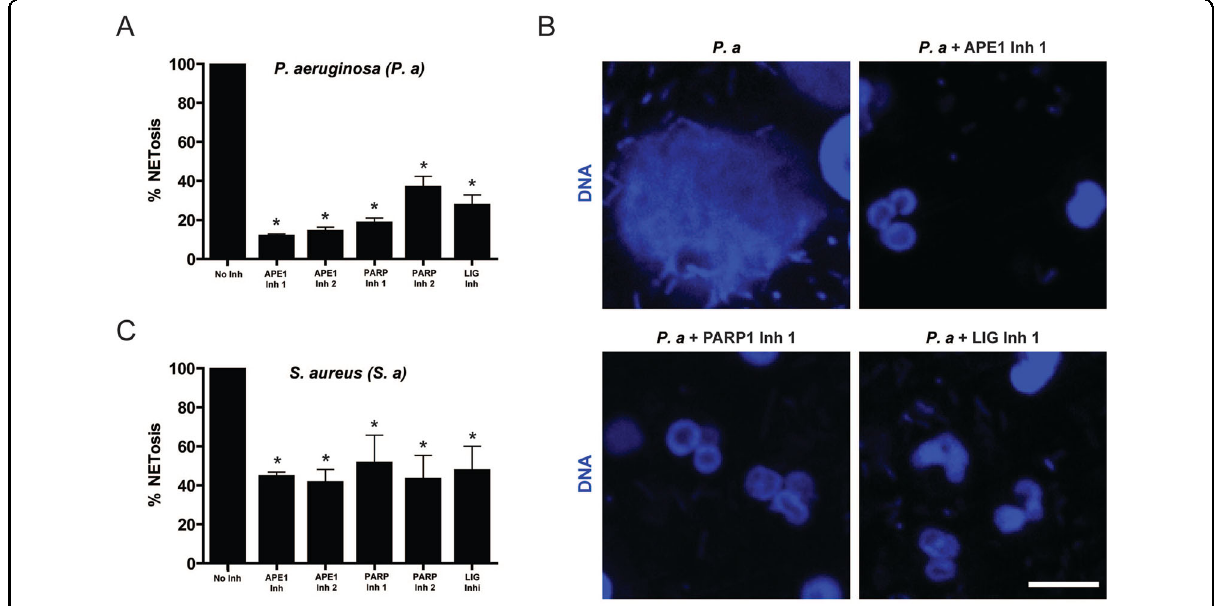
Fig. 4 Inhibition of early steps of BER suppresses NETosis induced by P. aeruginosa and S. aureus . A , C DNA release from neutrophils following media (-ve control), 20 MOI P. aeruginosa or 20 MOI S. aureus (RN4220) was measured using the SYTOX Green plate reader assay. Cells were preincubated with BER inhibitors (APE inh 1, CRT0044876 (125 μ M); APE inh 2, APE1 Inhibitor III (50 μ M); PARP1 inh 1, BSI201 (100 μ M); PARP inh 12, PJ34 (50 μ M) or LIG inh, L189 (100 μ M)) for 1 h prior to bacterial treatment. The data are presented a mean ± SEM ( n = 3; * p < 0.05 compared to the control with no inhibitors). B Neutrophils were incubated with DNA repair inhibitors, that inhibited NETosis, for 1 h then treated with 20 MOI P. aeruginosa and incubated for 240 min, and stained for DNA (DAPI, blue). The images are representative of three independent experiments. Scale bar, 10 μ